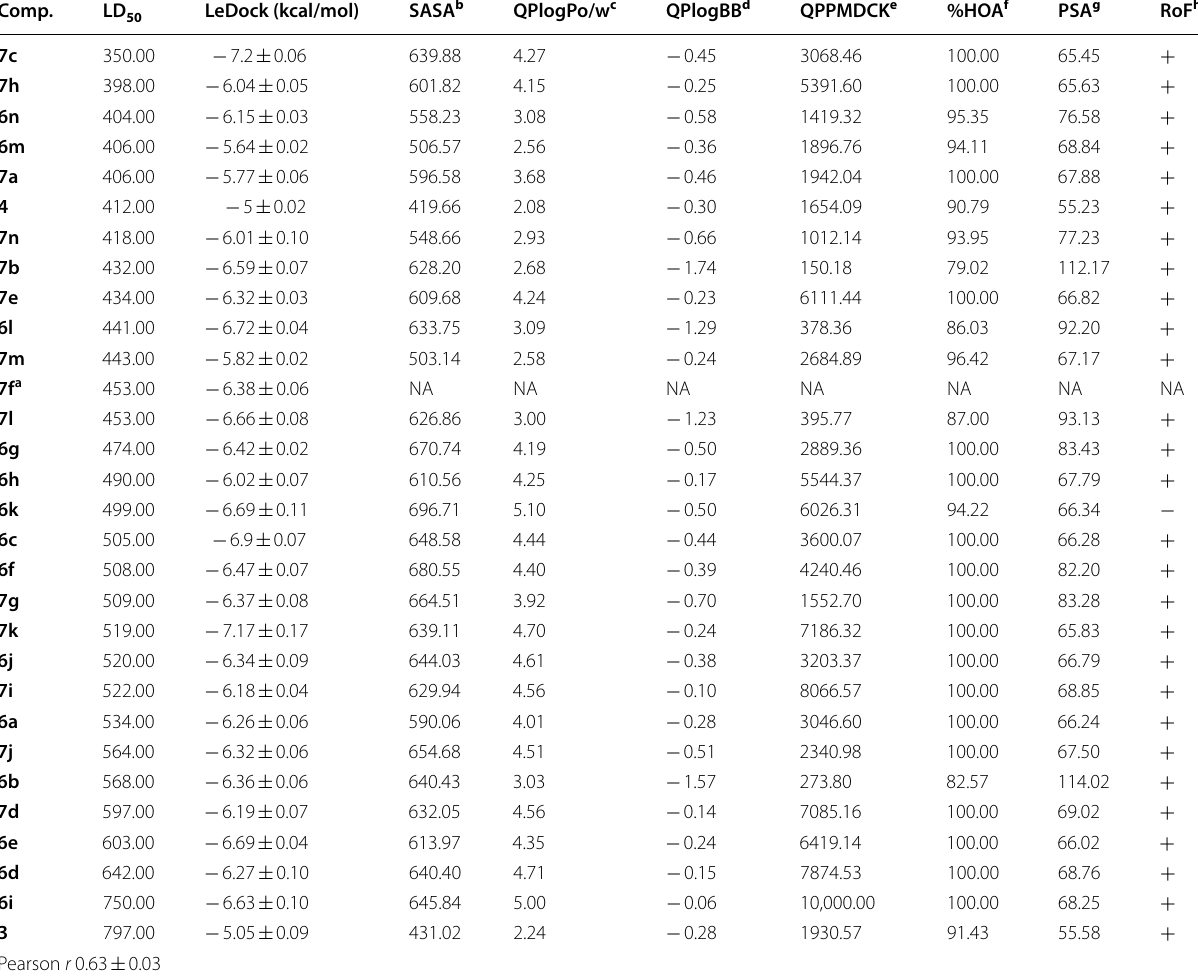
a ADMET values could not be calculated due to the steric clashes between methoxy substituents b Total solvent accessible surface area (SASA) in square angstroms using a probe with a 1.4 Å radius (recommended value: 300.0–1000.0) c Logarithm of the partition coefficient of the compound between n -octanol and water (recommended value < 5) d Predicted brain/blood partition coefficient (recommended value: 3.0 to 1.2) − e Predicted apparent MDCK cell permeability in nm/sec (< 25 poor, > 500 great) f Percentage of human oral absorption (< 25% is weak and > 80% is strong) g Polar surface area (recommended value 140 Å 2 ) [40] ≤ h Violations to the Lipinski’s rule of five